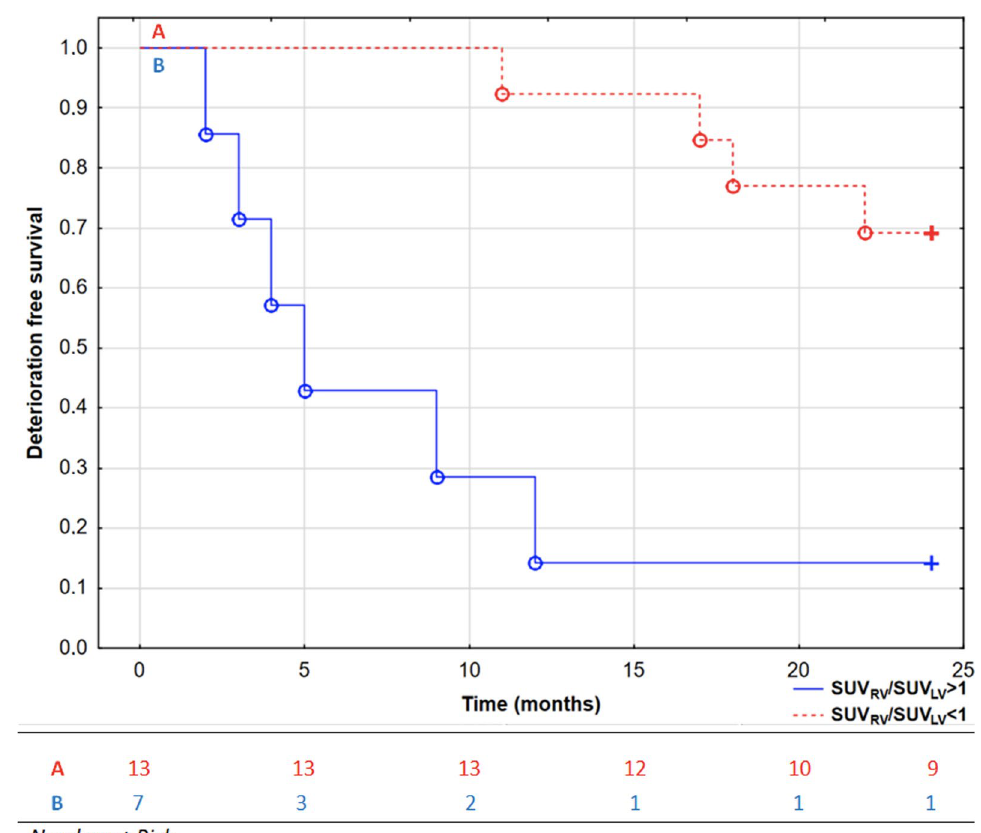
Fig. 4 Kaplan–Meier curves presenting deterioration-free survival in patients with pulmonary arterial hypertension based on SUV RV /SUV LV ratio after follow-up PET/MRI scans, log-rank test, p uptake